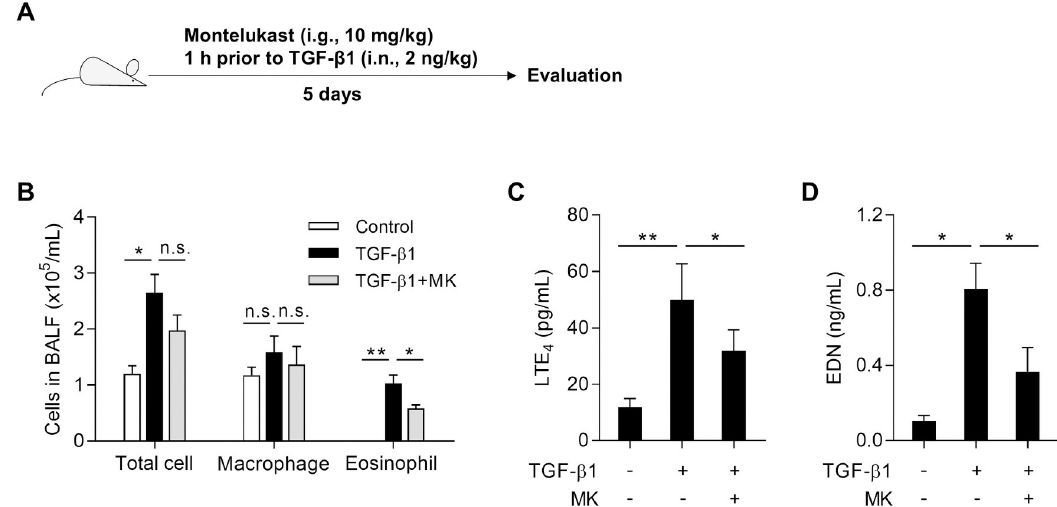
Fig 5. Roles of TGF- β 1 in the lipoxygenase pathway to produce LTE 4 in vivo . (A) Experimental schedule. (B) Differential cell count. Levels of (C) LTE 4 and (D) EDN in bronchoalveolar lavage fluid. Data are presented as mean ± SD, n = 6. � P < .05 and �� P < .01 were obtained by the Mann-Whitney test. n.s., not significant. i.n., intranasal injection; i.g., intragastric administration; MK,